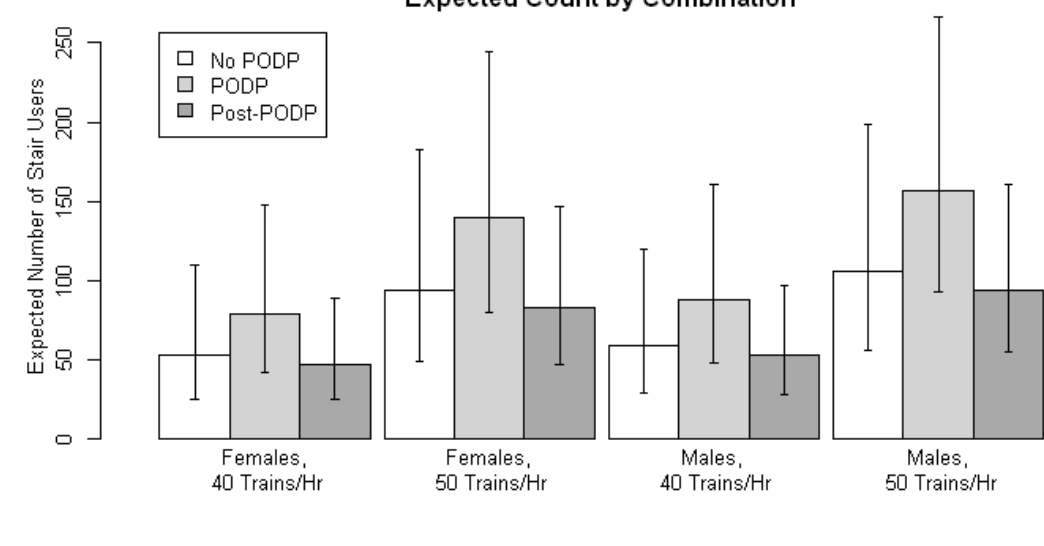
Figure 2. Expected number of stair climbers by gender, number of trains, PODP intervention, and post-PODP. Note that 40 trains/h and 50 trains/h are approximately the observed first and second tertiles,